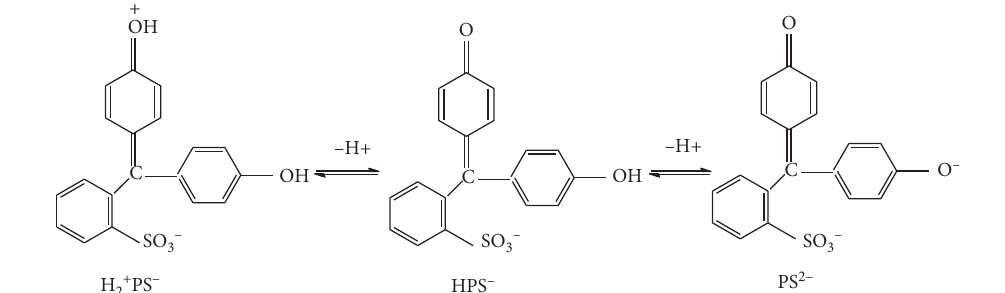
Scheme 1: Different forms of phenol red.